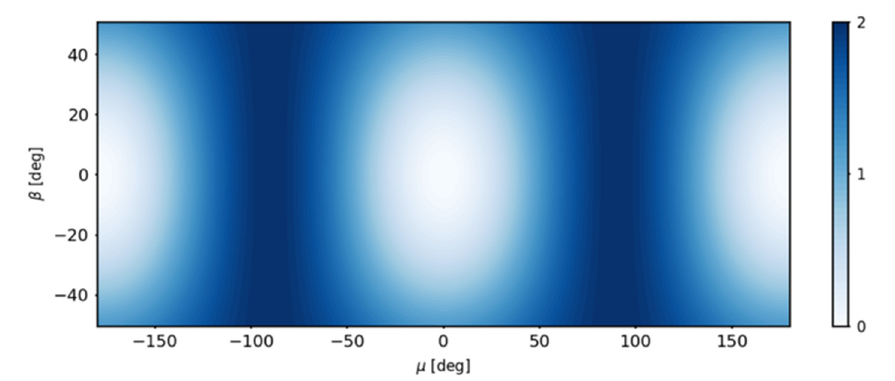
Figure 7. Simulated TRR-induced accelerations (unit: nm/s 2 ) along the D direction with distribution along the Sun elevation angle β and orbital angle μ for C13.